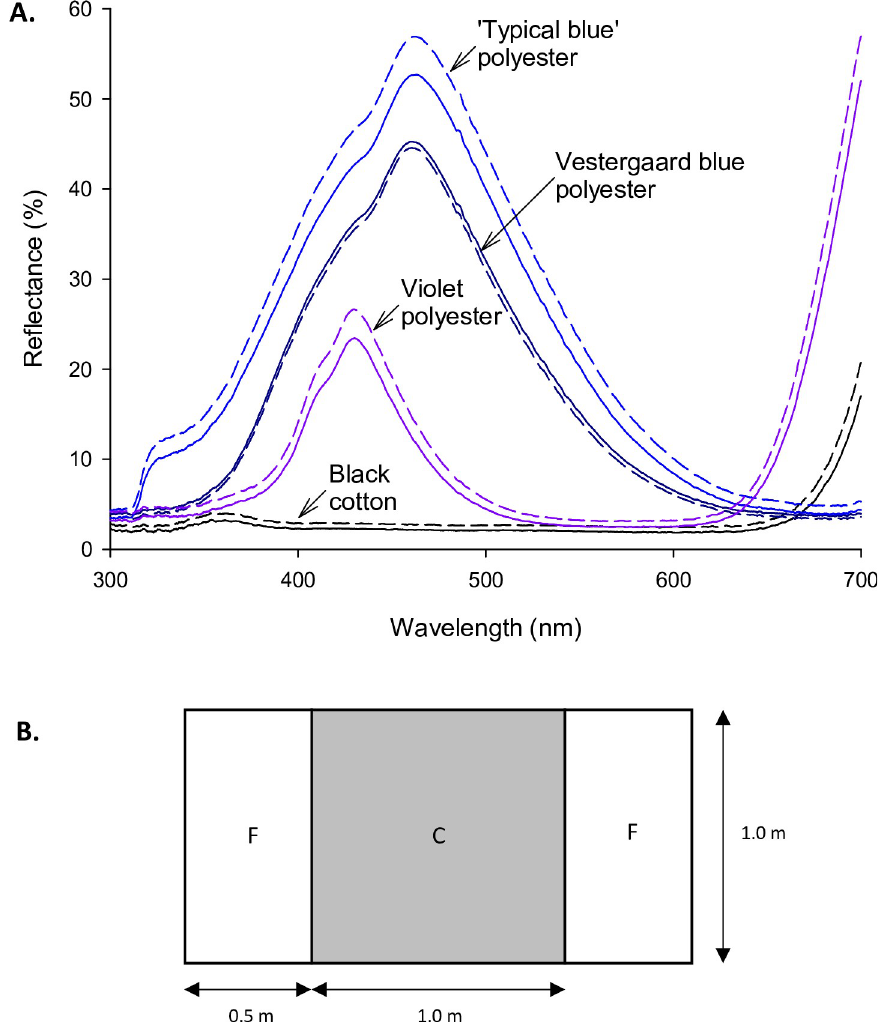
Fig 2. Fabric reflectance and target design. (A) Reflectance spectra for fabrics comprising the main panel of targets. Black cotton is the standard material for tsetse control devices in Zimbabwe, and ‘Vestergaard blue’ polyester is the fabric currently used in that company’s ZeroFly Tiny Targets for riverine tsetse. ‘Typical blue’ polyester and violet polyester were produced specifically for the current work by dyeing the same base polyester fabric and thus controlling for fabric properties other than colour. In particular, violet polyester was designed for increased attractiveness to tsetse using photoreceptor-based models. Solid lines are reflectance spectra with the reflectance probe oriented parallel to the bottom edge of the fabric; dashed lines are spectra recorded with the probe oriented at 90˚ to the bottom edge. Because spectra were similar for each side of the fabric, an average across the two sides has been plotted. (B) Fabrics were tested using the same target design which comprised a central fabric panel (‘C’) and flanking panels to each side (‘F’). The fabrics comprising these panels in each target design are listed in Table